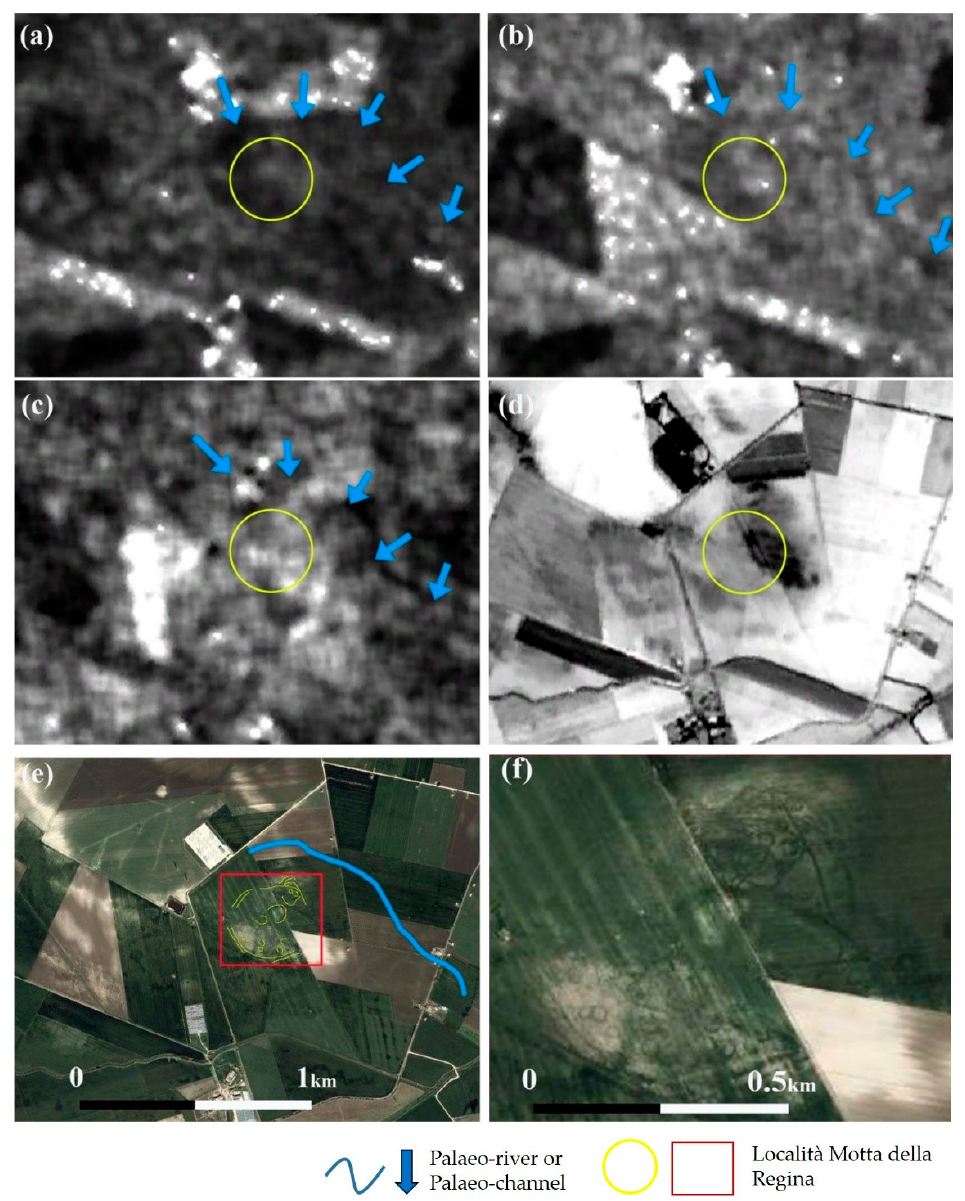
Figure 11. Motta la Regina, palaeo-landscape (see Figure 8III for its location) including a palaeo-channel observed from: ( a ) VH Sentinel 1 data acquired on 19 October 2019; ( b ) VV Sentinel 1 data acquired on 19 October 2019; ( c ) VV Sentinel 1 data acquired on 28 October 2016; ( d ) Sentinel 2 based soil map acquired on 20 October 2019; ( e ) Google Earth image acquired on 10 October 2014; ( f ) zoom from Figure 11e including crop-marks related to double curvilinear ditches and smaller circular features of the Neolithic settlement.